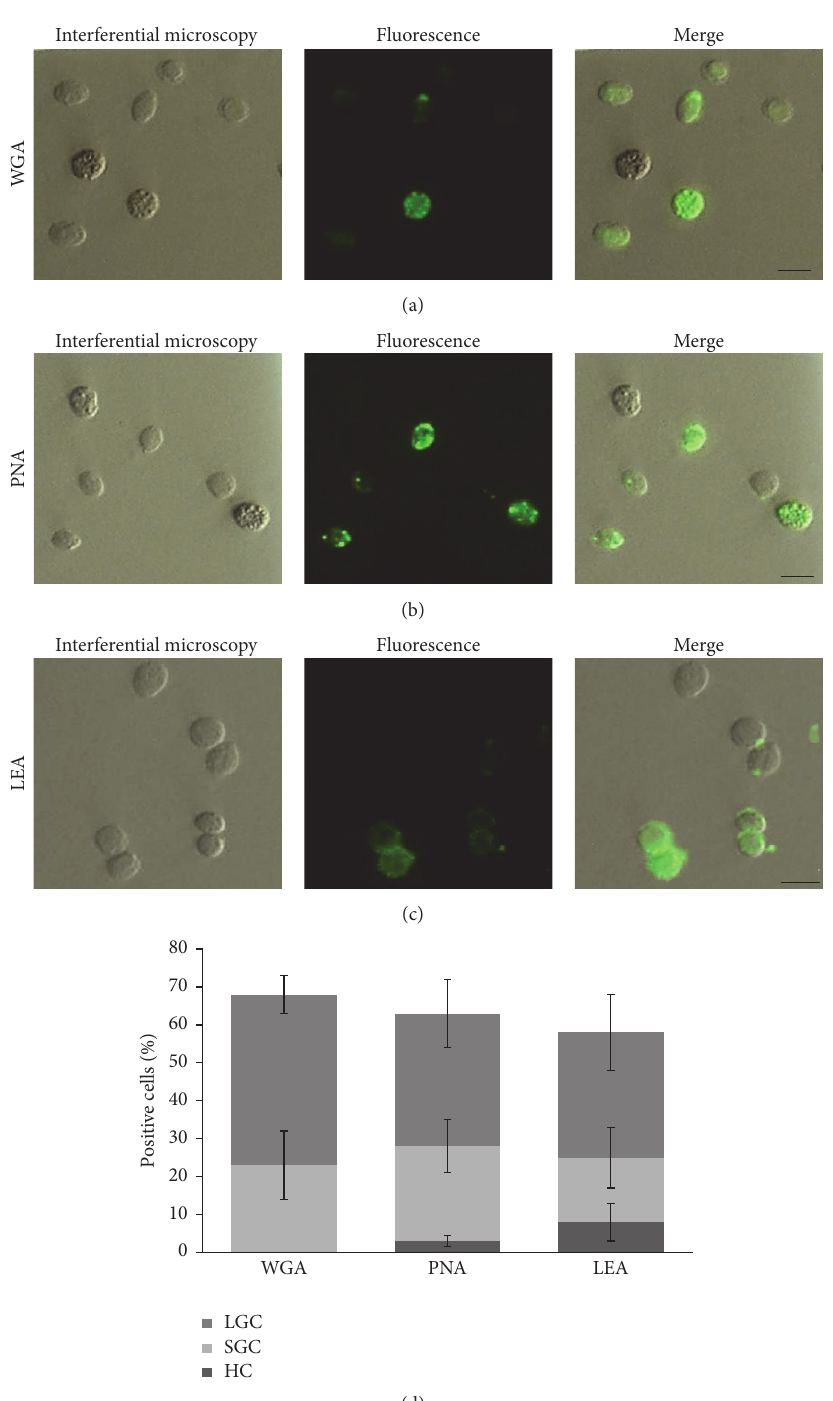
Figure 2: Labeling pattern of fixed hemocytes isolated from Litopenaeus vannamei after incubation with FITC-conjugated lectins. Many hemocytes express ligands differentially: (a) wheat germ agglutinin (WGA), (b) peanut agglutinin (PNA), and (c) Lycopersicon esculentum agglutinin (LEA). Hemocytes were evaluated by interference contrast microscopy and epifluorescence microscopy. Scale bar = 5 𝜇 m. (d) Percentage of total hemocytes and cell types of positive cells labeled by FITC-conjugated lectins. For each treatment, digital images were used to analyze at least 500 hemocytes. The percentage of positive (i.e., fluorescing) cells per sample was calculated, as defined with reference to the total hemocyte number. Data represent mean ±